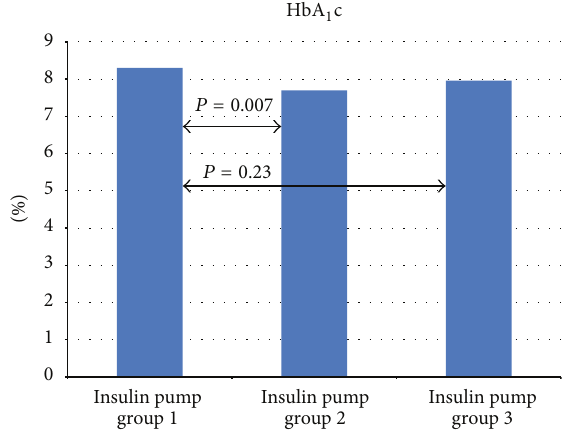
Figure 1: Change in HbA 1 c in the insulin pump group during 6 months of using new treatment method (1—before CSII, 2—after 3 months of CSII, and 3—after 6 months of CSII).